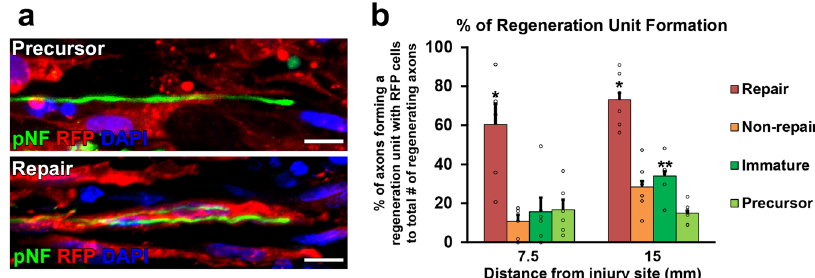
Fig. 4 Regeneration unit formation by grafted RSCs. a High magni fi cation images of regenerating axons (pNF, green) and grafted cells (RFP, red). Arrowheads indicate regenerating axons, which are tortuous and have growth cone-like morphology. The upper image is a representative example of the lack of a regeneration unit formation by grafted RFP expressing SCPs. RFP expressing SCPs have no association with a regenerating axon. In contrast, the lower image shows that RFP expressing RSCs form a regeneration unit with regenerating axons. Scale bars, 10 μ m. Left is proximal. b Quanti fi cation of regeneration unit formation. Percentages of axons forming a regeneration unit with RFP + cells to total # of regenerating axons were quanti fi ed. Grafted RSCs have a great capacity to form regeneration units. Six rats per group. * P < 0.05 vs. others. ** P < 0.05 vs. SCPs. One-way ANOVA with the Tukey-Kramer test. Error bars represent the